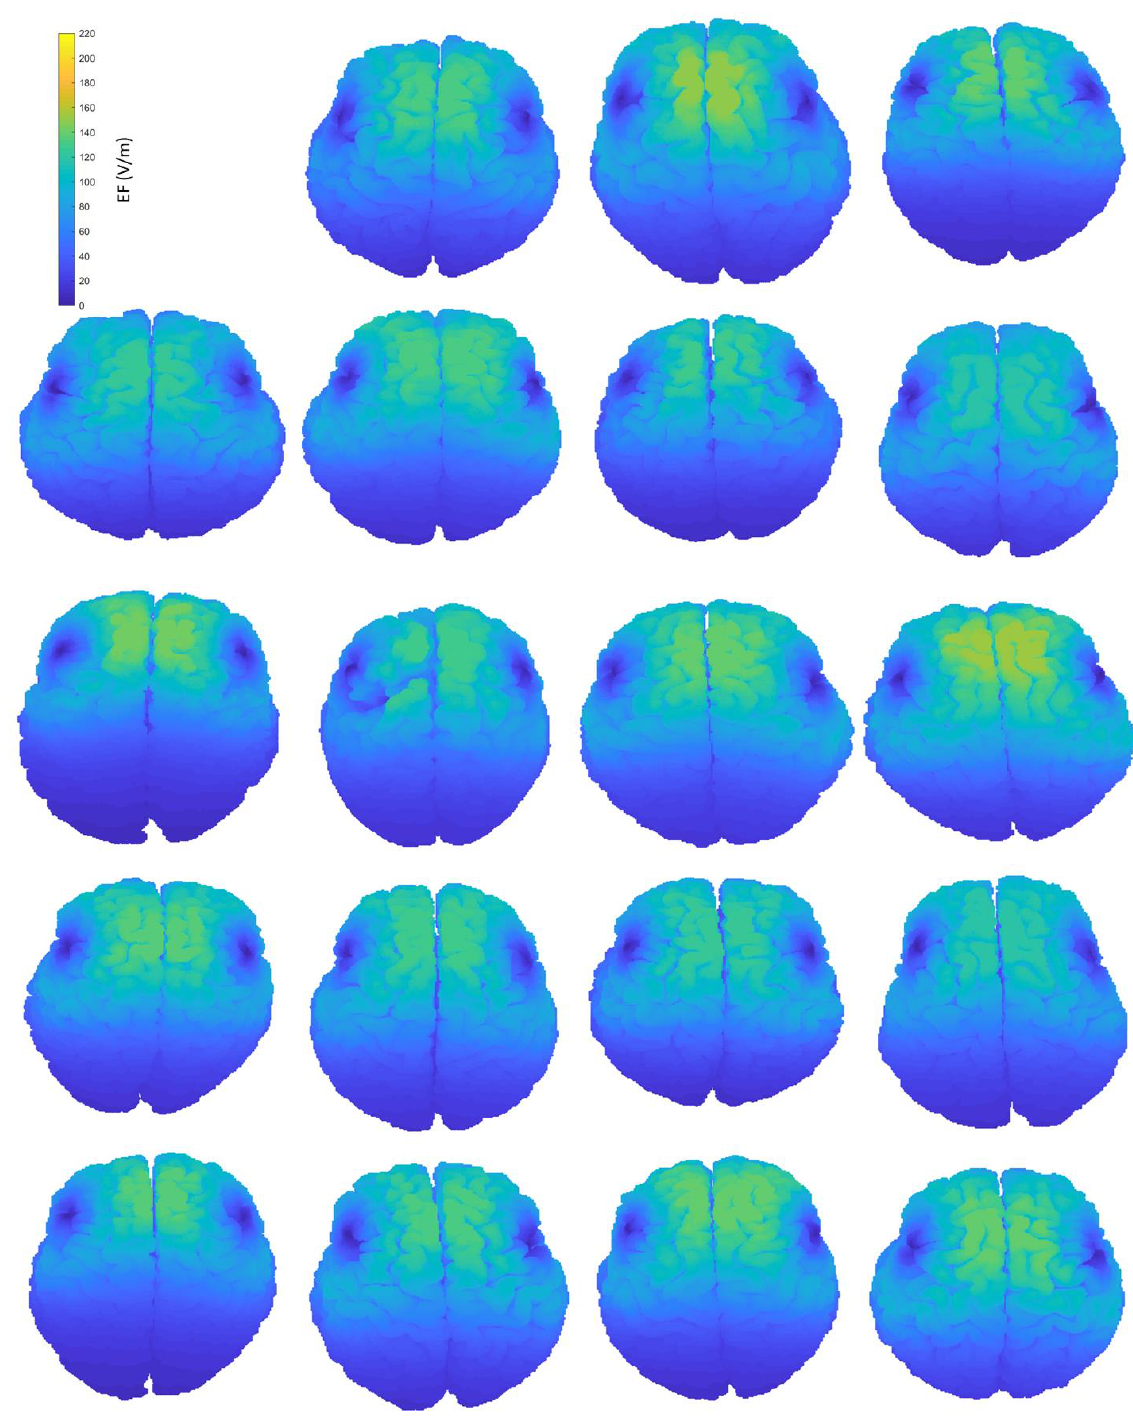
Figure A2. Interindividual variability of the induced EF distributions visualized on subjects’ homo- geneous brains, containing both grey and white matter, when the coil is placed at frontal position.